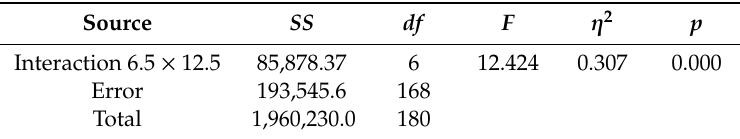
Table 3. Factorial ANOVA